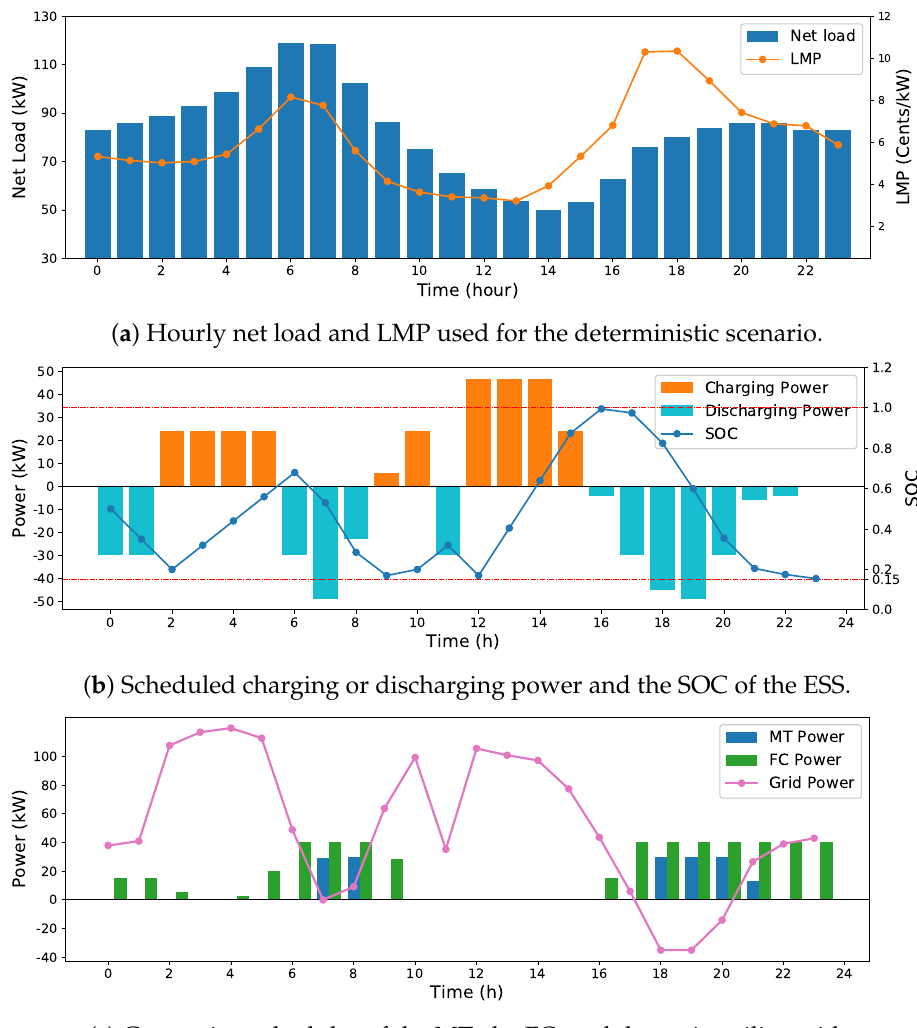
Figure 4. MG schedules yielded by the proposed DRL approach with an initial SOC of